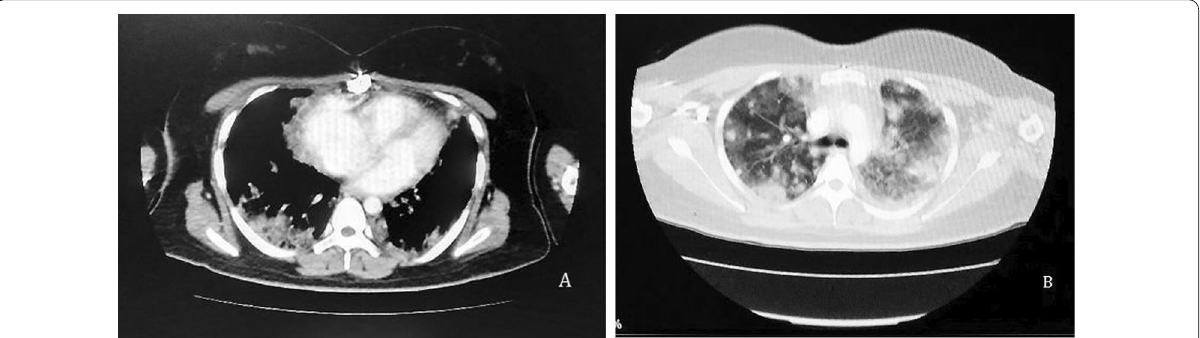
Fig. 1 High-resolution computed tomography (HRCT) of the patient showing A mild pleural effusion with dilated left atrium and B bilateral pulmonary multi nodular consolidations